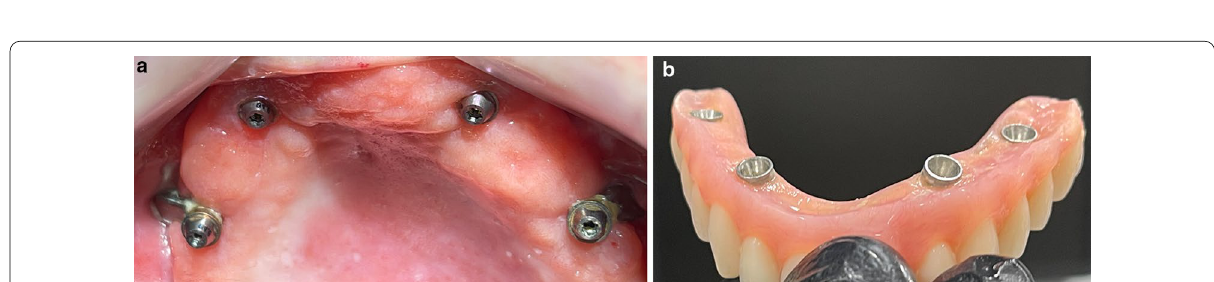
Fig. 11 a Intraoral picture of patient 11. Soft tissue dehiscence was present on the two posterior zygomatic implants and not on the anterior ones. Although there is plaque accumulation the mucosa is not inflamed. b Gingival view of the immediate prostheses of patient 11. Note the